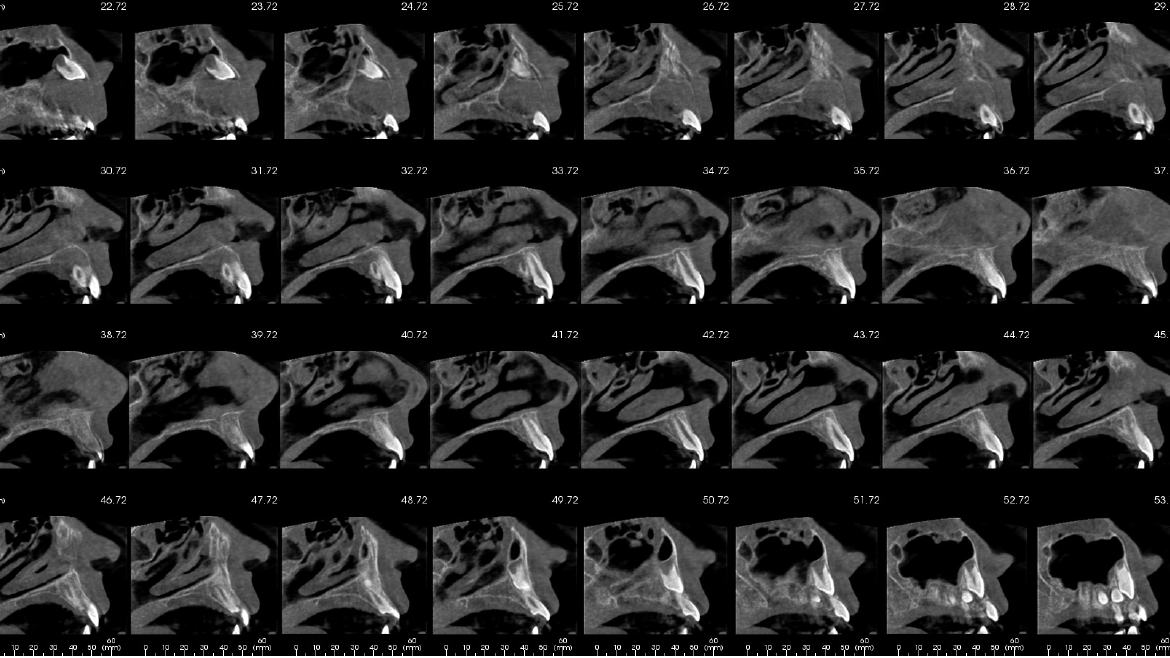
Figure 4. CBCT before treatment—sagittal view.